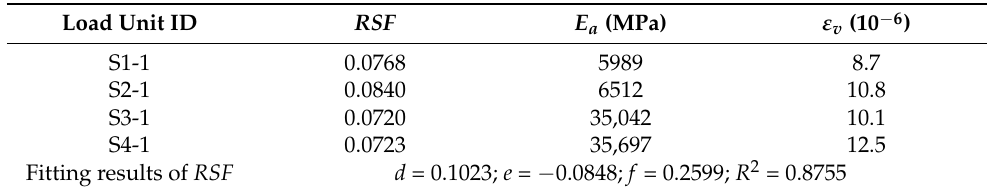
Table 4. Initial calibration data and results of the rut shift factor function, based on the test results in the initial load